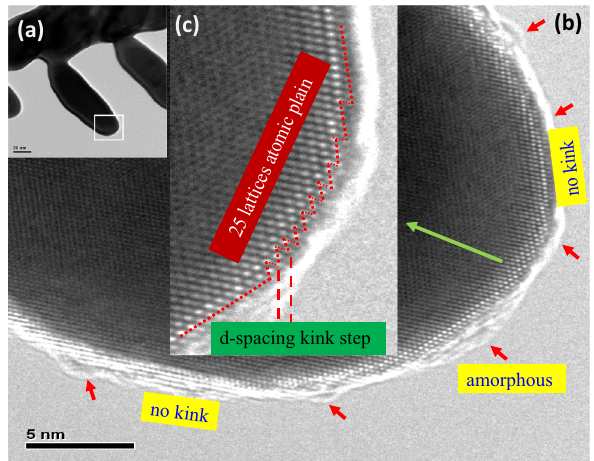
Figure 5. The caption to be typeset alongside it: ( a ) The dendrite arm without globule attachment still exhibited growth behavior indicative of a high aspect ratio. The growth behavior was closely related to the high surface energy of the tip area, which enabled rapid adsorption of atoms. ( b ) The high-resolution TEM image reveals the rim of the amorphous nano covering surrounding the curved region of the arm tip, as indicated by red arrows. The upper right top and lower left bottom show straight linear lattice structure with no kinks. ( c ) The tip end shows zig-zag kink steps for which the kink step has a one d-spacing. The zig-zag structure area is comprised of 25 lattices forming an atomic plane when extended two dimensionally. ( d ) Top view simulation sketch presents the 25 lattices atomic plane on the dendrite tip with an average roughness (Ra) of one d-spacing and the fronts of the lattice segment from the atomic plane. The kinks provided the high surface energy for atom adsorption that favored the growth of the secondary dendrite arm in the longitudinal direction. The numbered planes show extending segment of the underneath lattice plane that form the zig-zag structure. The round curvature of the dendrite tip is formed with short segments, planes